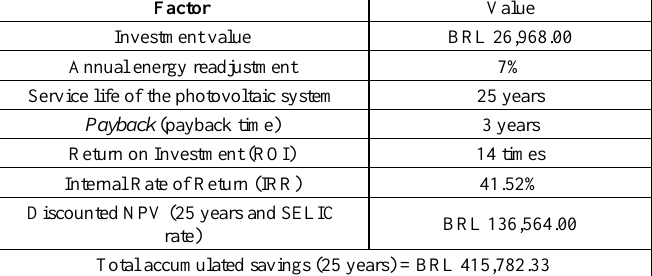
Table 6: Financial viability